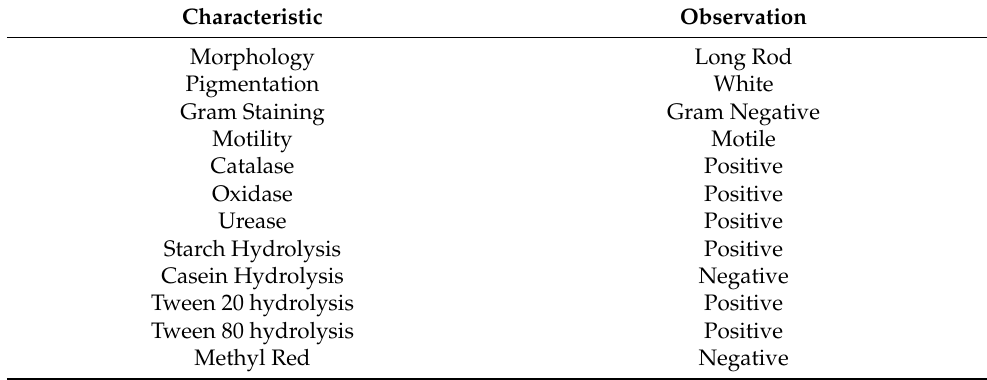
Table 2. Observations of biochemical tests performed for Halomonas meridiana VITSVRP14.